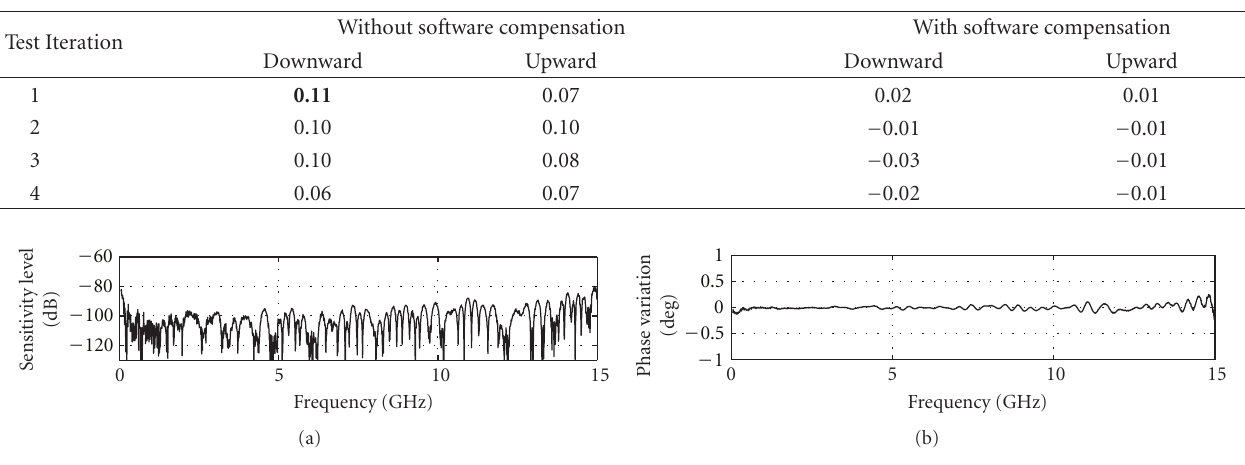
Table 1: Measured mechanical play for the elevation axis. All values are in mm.